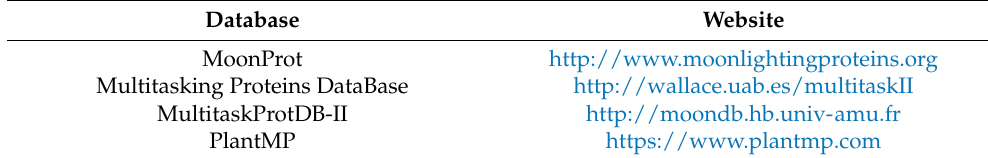
Table 3. Databases of moonlighting proteins (MLPs). Adapted from [43–45]. (accessed on 21 June 2022).